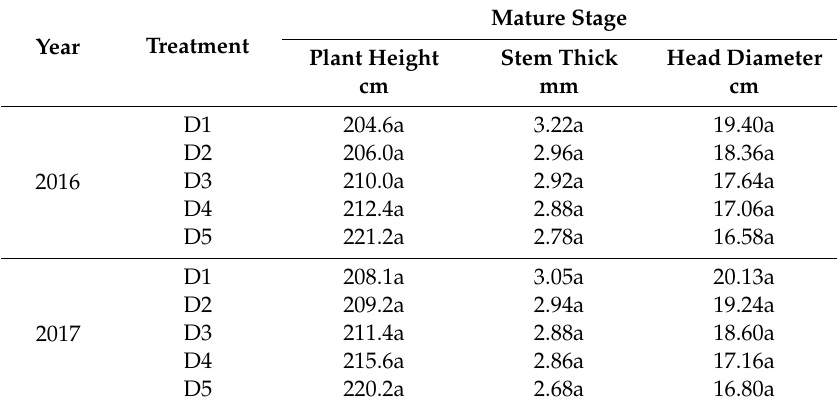
Table 6. Maximum morphological index of